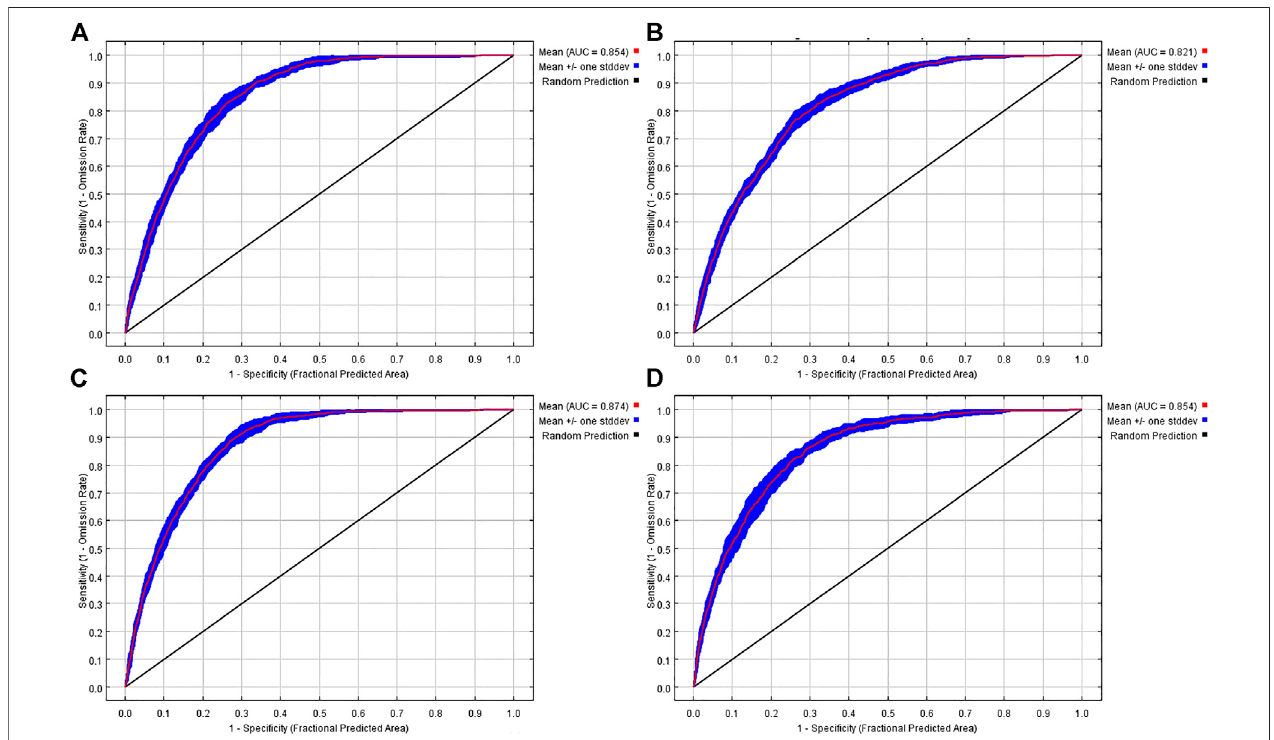
FIGURE 3 | AUC values of ROC curves of Abies (A) , Picea (B) , Quercus (C) , and Betula (D)